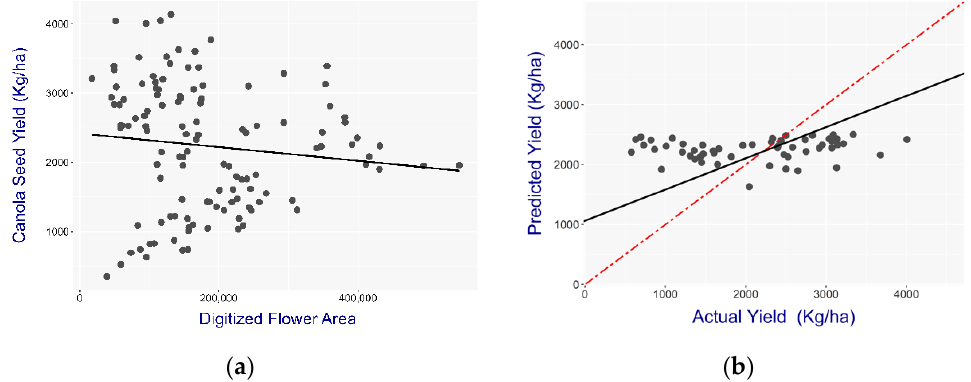
( b ) Figure 9. ( a ) The trained model and ( b ) the scatterplot of the measured vs. predicted canola seed yield for the testing set developed for the image acquired during peak flowering (Model 2). Red line indicates the 1:1 line. Table 5. Parameter estimates of the trained simple linear regression model for the image acquired during late flowering (23 July).